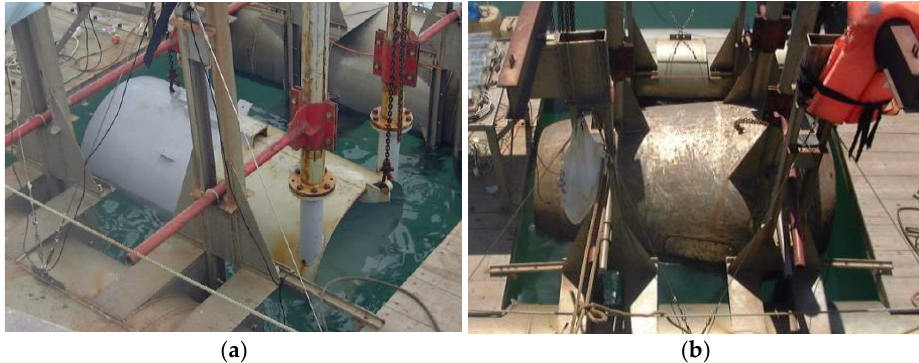
Figure 5. The duct scale models D2 ( a ) and D4 ( b ) at the higher level (partially immersed in the water) when the platform was tied to the quayside.